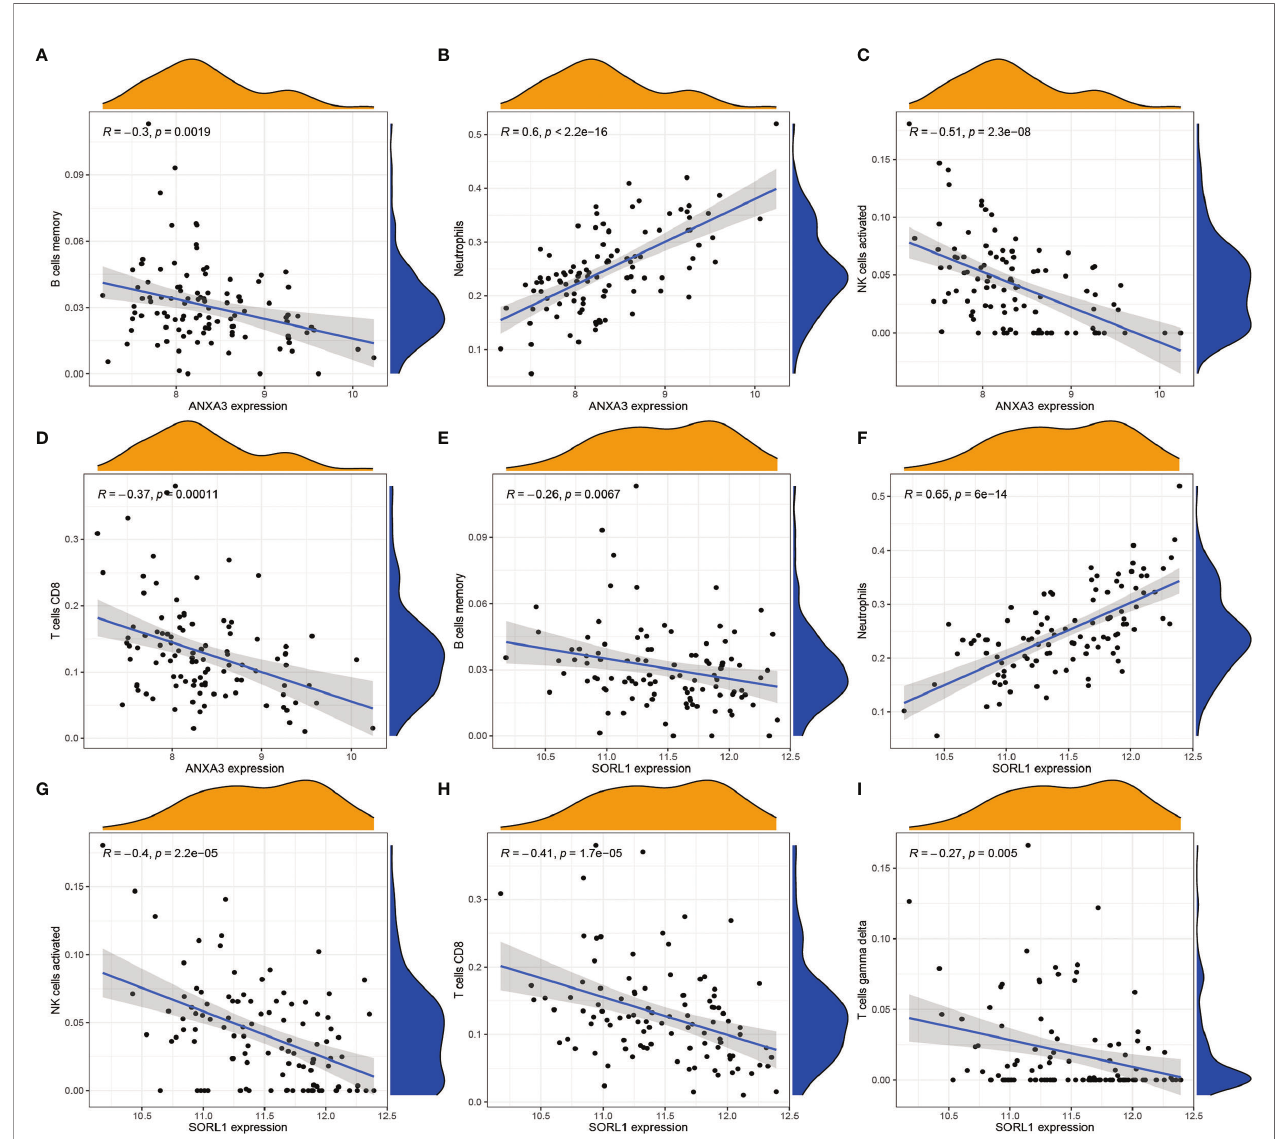
FIGURE 7 | Correlation analysis of ANXA3, SORL1 and immune cells respectively. (A-D) shows the correlation analysis of ANXA3 and 4 immune cells. (E-I) shows the correlation analysis of SORL1 and 5 immune cells. If R > 0, it means higher gene expression and higher immune cell content; if R < 0, it means higher gene expression and lower immune cell